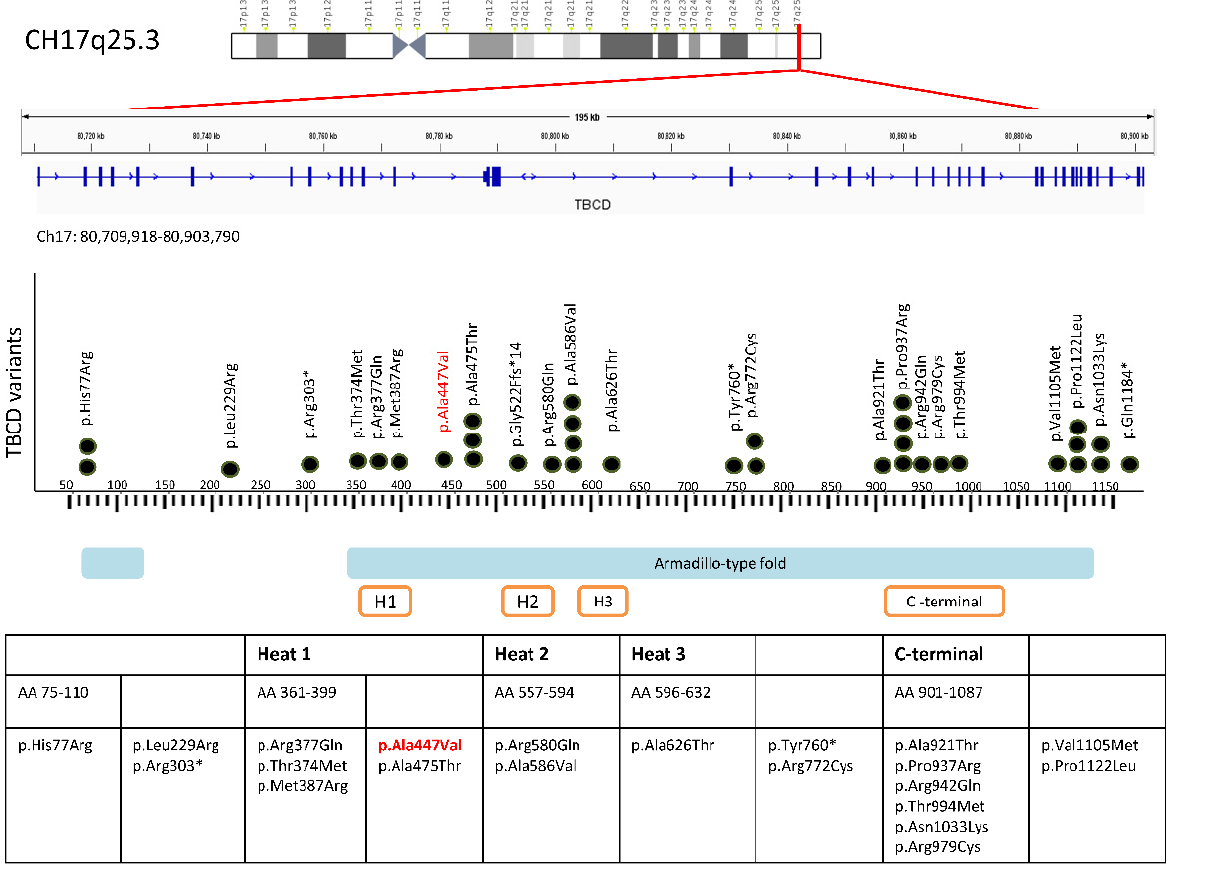
Figure 3. Schematic representation of TBCD gene located at chromosome 17q25.3, and its expressed TBCD protein product. The TBCD variants published in the previous literature associated with phenotypes of early-onset neurodegenerative encephalopathy are plotted in from N-terminal to C-terminal. Our reported variant is highlighted in red. Black dots represent the number of times a particular variant has been reported. Solid blue and orange-framed bars indicate the domains and repeated sequence motifs present in a TBCD protein. The insertion/deletion variant c.771+1_771+10del and splice site variants c.1564-12C>G, c.3192-2A>G, c.817+2T>C are not included. The star sign (*) denotes termination of the amino acid sequence, resulting in protein truncation.